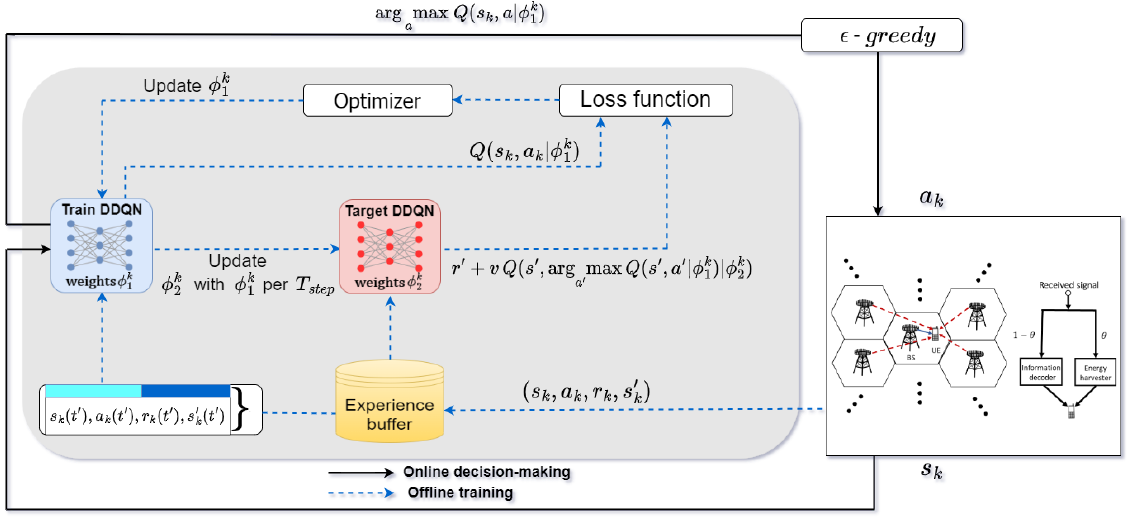
Figure 2. Structure of the proposed distributed DDQN algorithm in the multi-agent system.